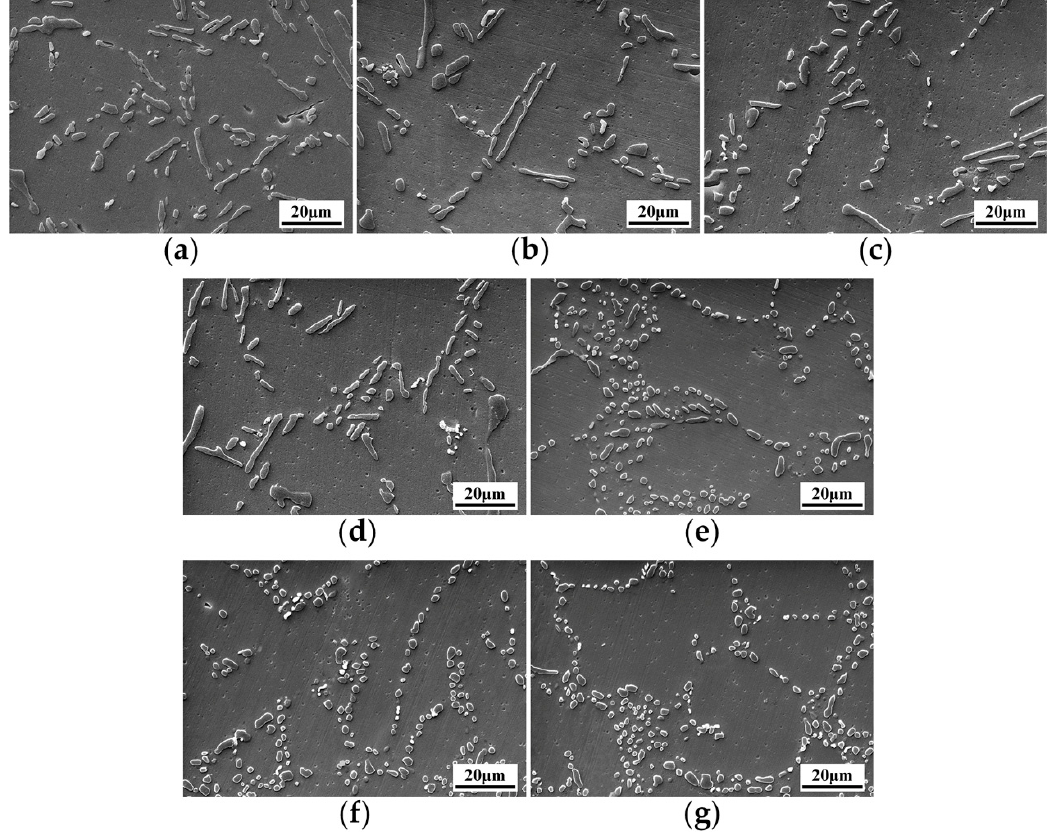
Figure 3. SEM microstructure of eutectic silicon in Al-8Si alloys with different contents of modifiers after T6 heat treatment: ( a ) unmodified + T6, ( b ) 0.1 wt.% Sb + T6, ( c ) 0.3 wt.% Sb + T6, ( d ) 0.5 wt.% Sb + T6, ( e ) 0.04 wt.% Sr + T6, ( f ) 0.08 wt.% Sr + T6, ( g ) 0.12 wt.% Sr + T6.